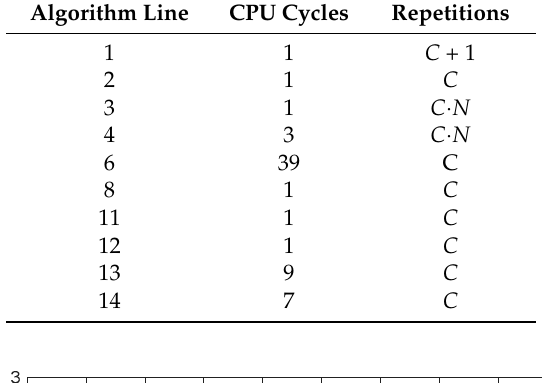
Table 3. Computational cost of Algorithm 2.